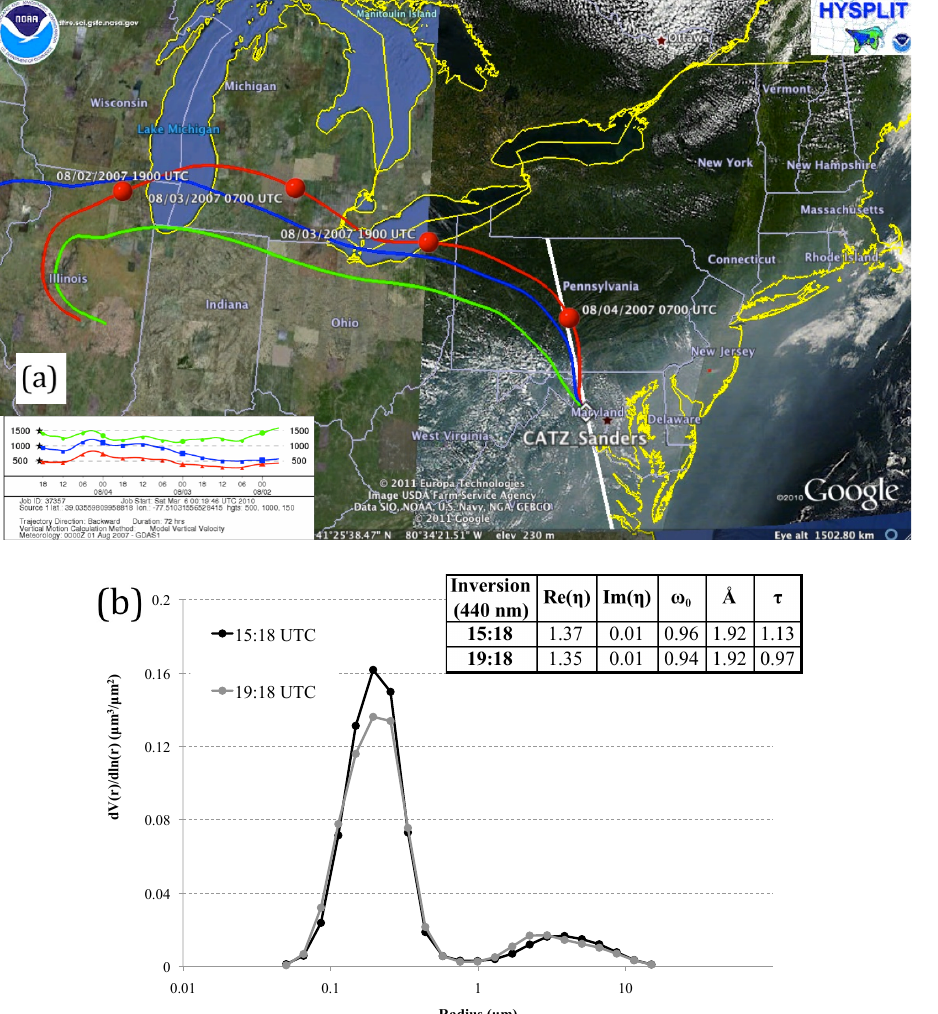
Fig. 1. 4 August 2007 – (a) MODIS true color RGB image over the East Coast of the United States, 72h-HYSPLIT air mass back-trajectories at 500 (red), 1000 (blue) and 1500 (green) meters above model ground level arriving at 19:00 UTC over CATZ-Sanders (white diamond) and the CALIOP ground track (white line); the back-trajectories are computed using the gridded meteorological data archives of the National Weather Service’s (NWS) National Centers for Environmental Prediction (NCEP) Global Data Assimilation System (GDAS) model; (b) Version 2-level 1.5 CATZ-Sanders AERONET observations derived from the angular distribution of sky radiance in the almucantar (2